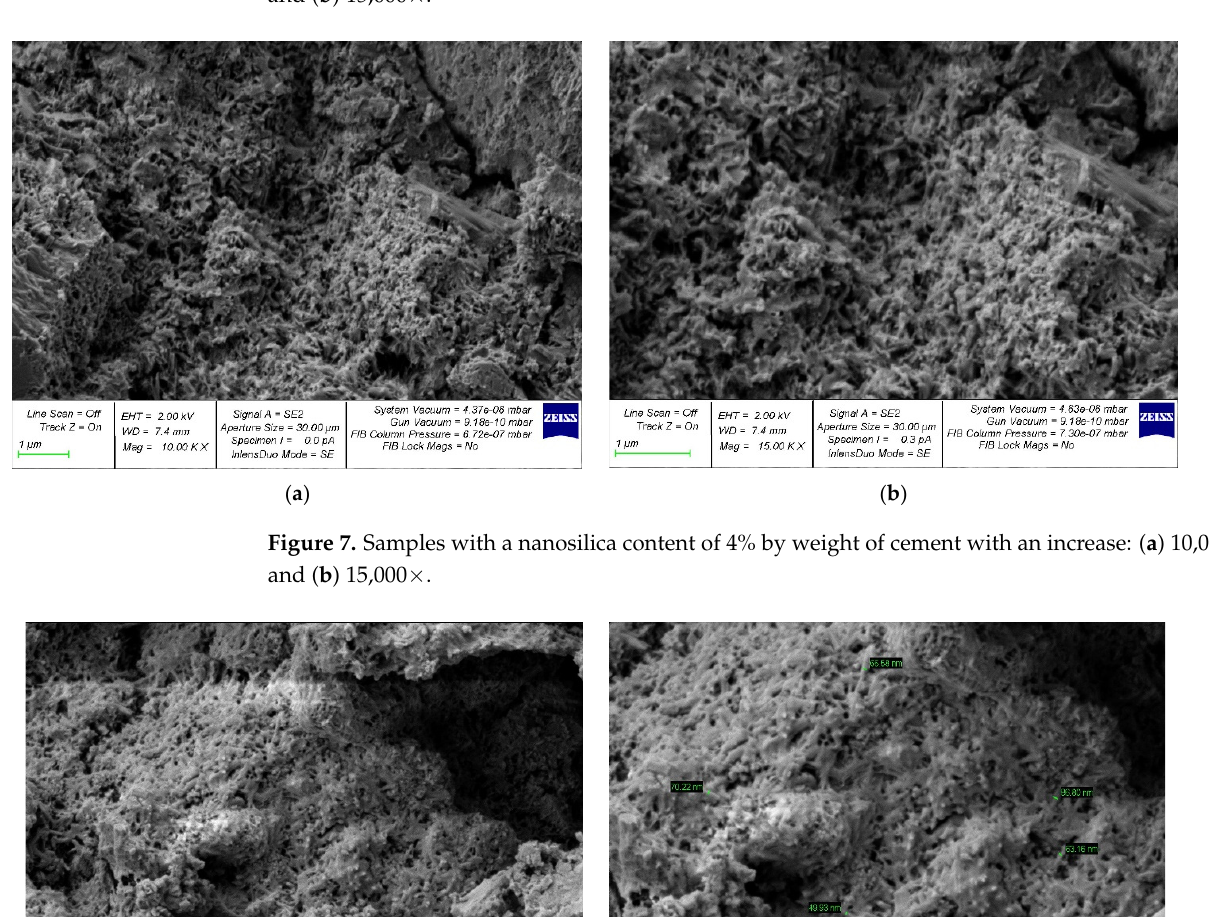
Figure 6. Samples with a nanosilica content of 3% by weight of cement with an increase: ( a ) 10,000× and ( b ) 15,000×.